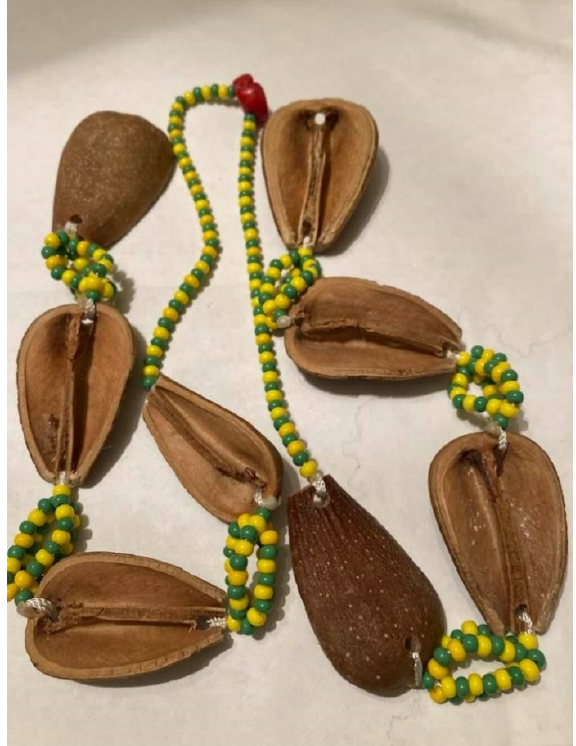
Figure 3. Ékuele chain, from the author’s collection, green and yellow are colors of Orunmila , the deity of wisdom and divination. Interestingly, Orunmila is syncretized with Francis of Assisi, who is famous, in particular, for his ability to speak the language of birds and animals.